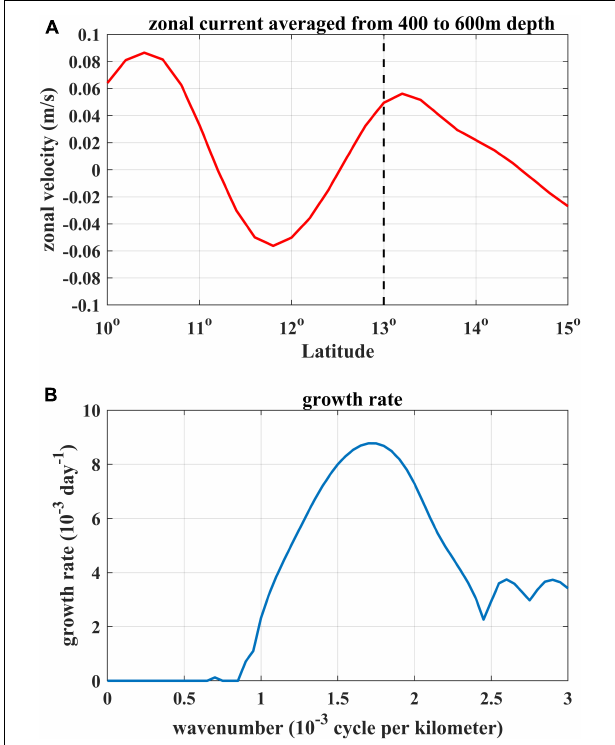
FIGURE 14 | (A) Mean zonal velocity (400–600 m) averaged between 128 ◦ and 132 ◦ E from OFES outputs in 2010. (B) Growth rate as a function of zonal wavenumber k calculated from the 1.5-layer linearized reduced gravity